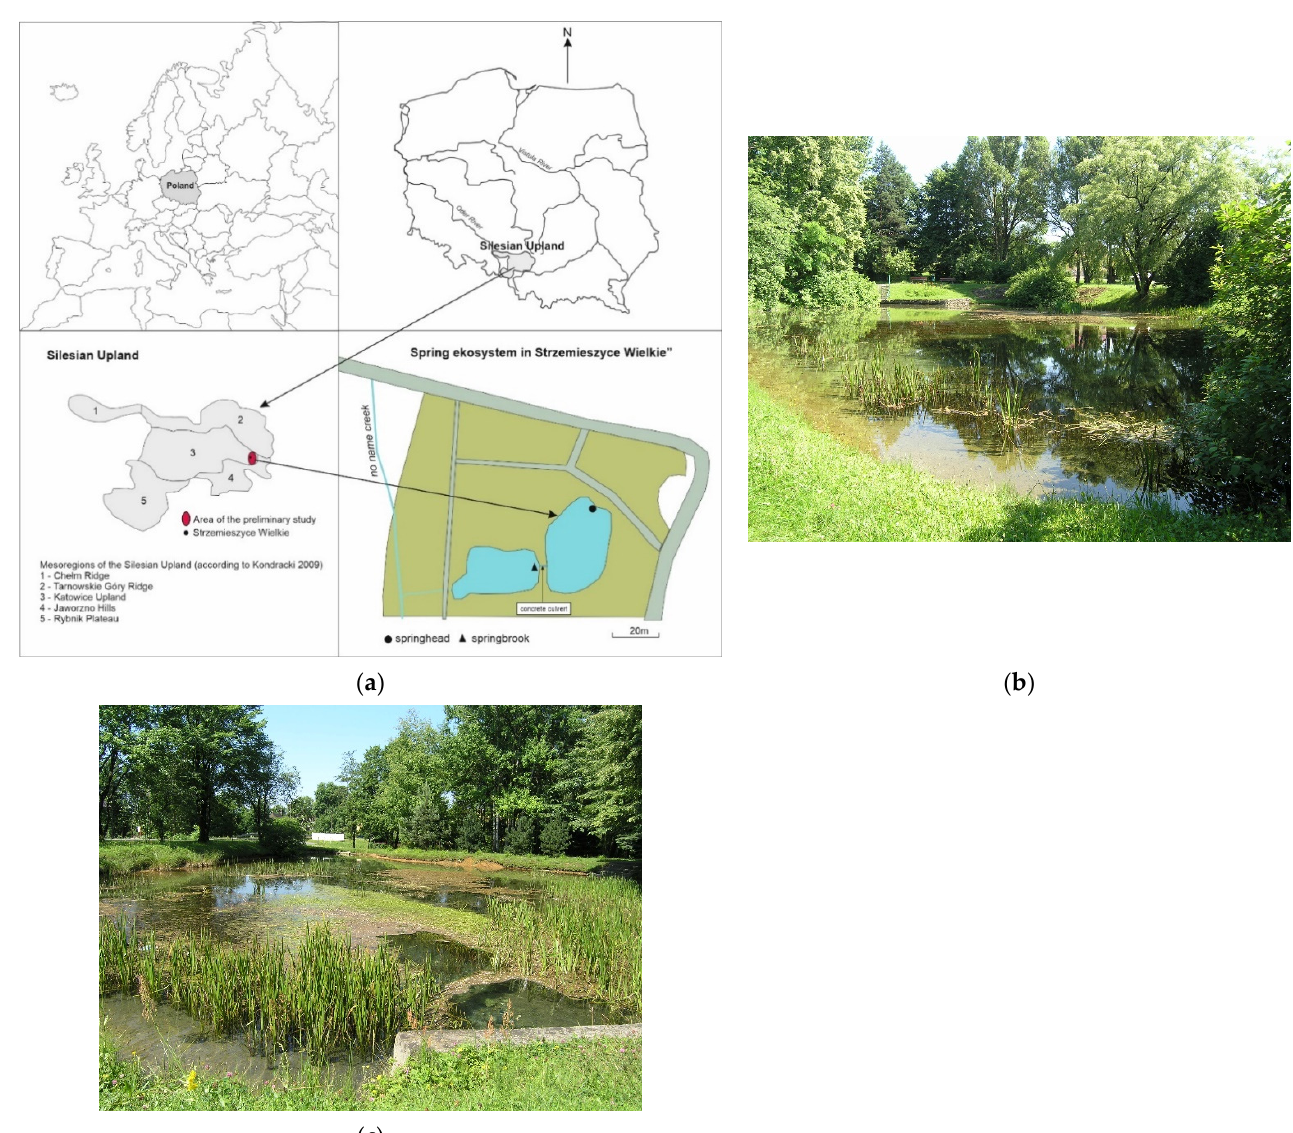
Figure 1. ( a ) Location of the study area; ( b ) spring in the bottom of a pond in Strzemieszyce Wielkie; ( c ) pond into which waters from the spring flow.